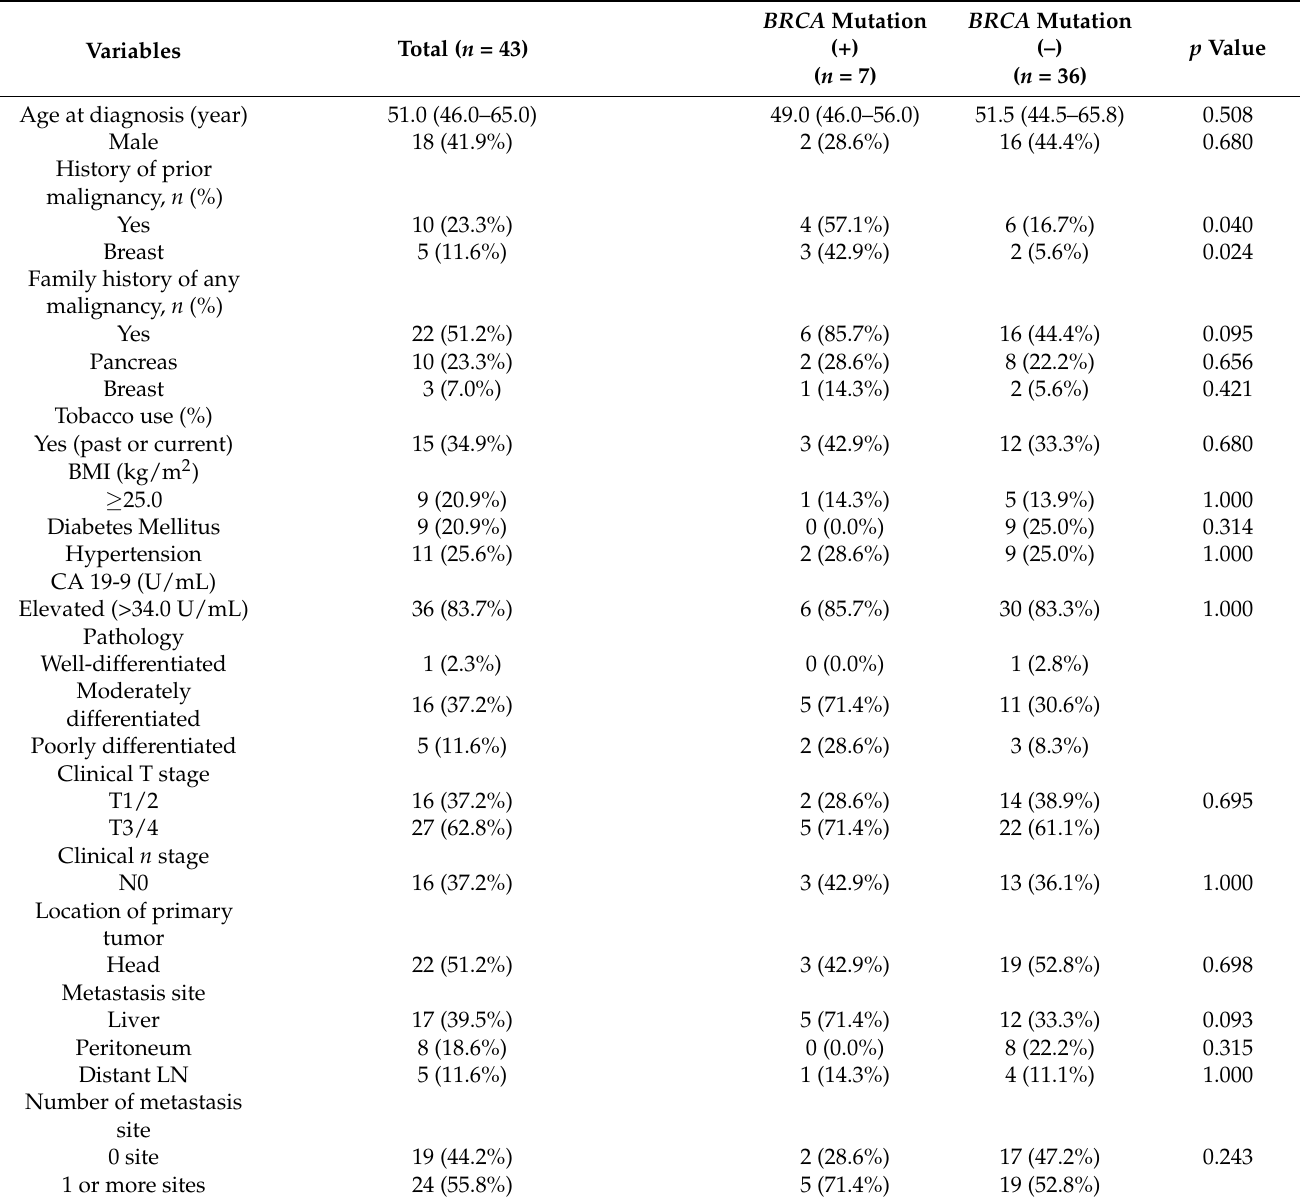
Table 2. Baseline characteristics of the patients who received FOLFIRINOX treatment and had response evaluation